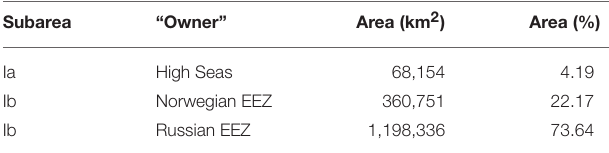
TABLE 2 | Surface areas of individual ICES subareas in the Barents Sea, including EEZ division as derived by the Sea Around Us (Zeller et al., 2016). The Norwegian EEZ includes Svalbard